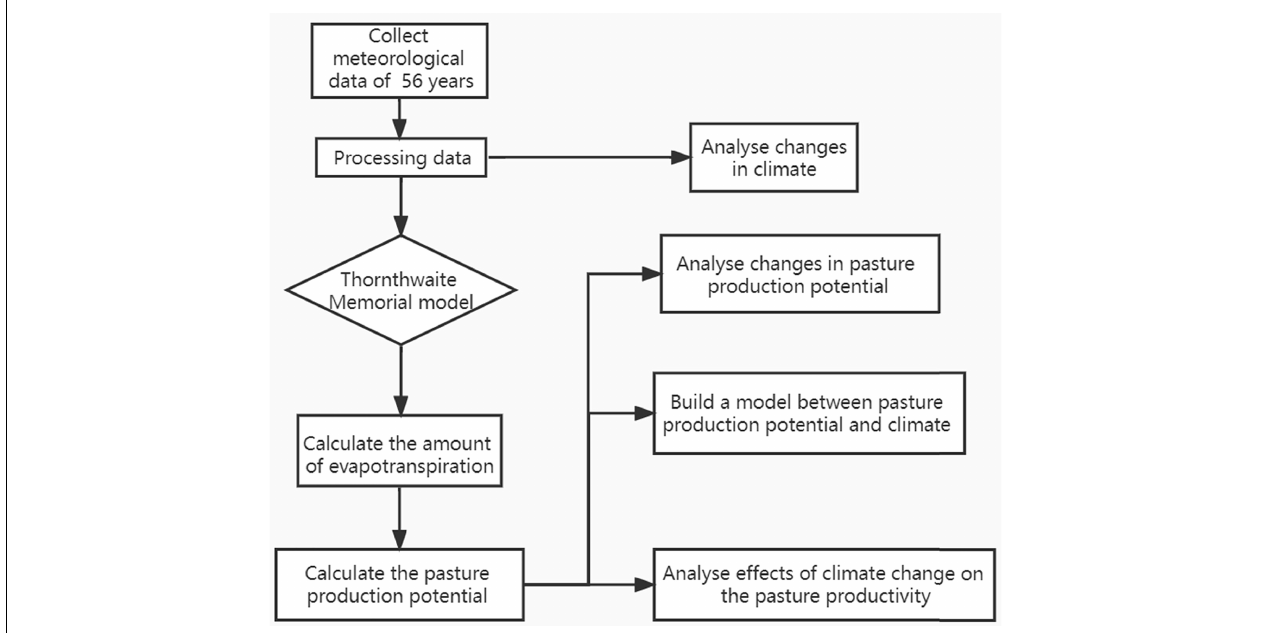
FIGURE 2 | Technical